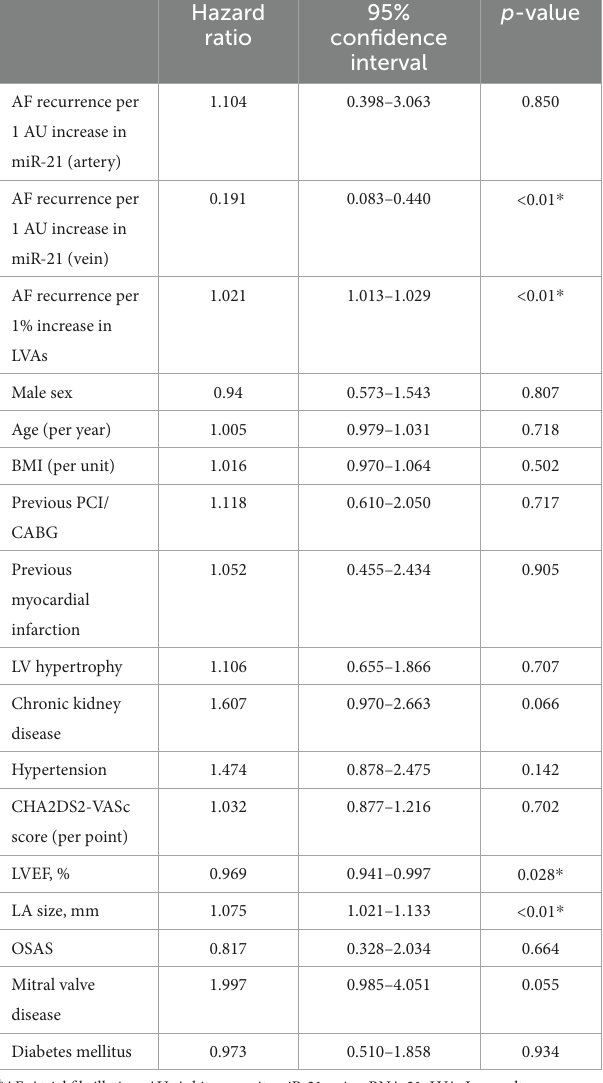
TABLE 2 Clinical characteristics and risk factor associated with AF